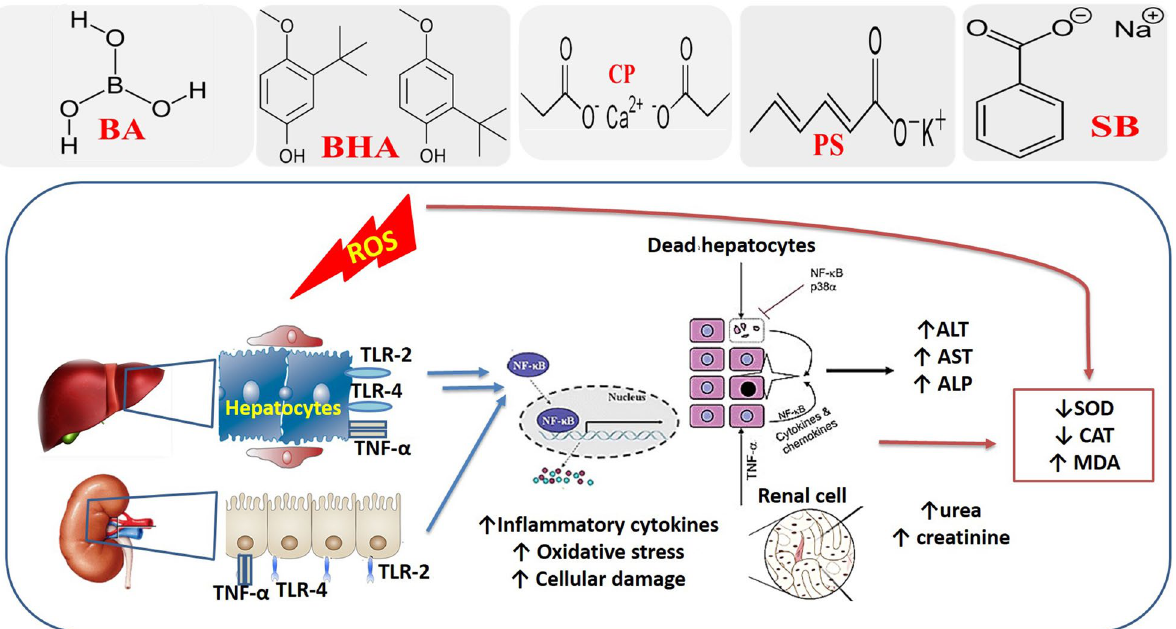
Figure 6. Schematic presentation of the proposed mechanism of hepatorenal damage induced by potassium sorbate (PS), butylated hydroxyanisole (BHA), sodium benzoate (SB), calcium propionate (CP), and boric acid (BA). ALP alkaline phosphatase, ALT alanine transaminase, AST aspartate transaminase, CAT catalase, CP calcium propionate, GSH reduced glutathione, MDA malondialdehyde, NF-κB nuclear factor kappa-light-chain- enhancer of activated B cells, SOD superoxide dismutase, TLR-2 toll-like receptors 2, TLR-4 toll-like receptors 4, TNF-α tumor necrosis